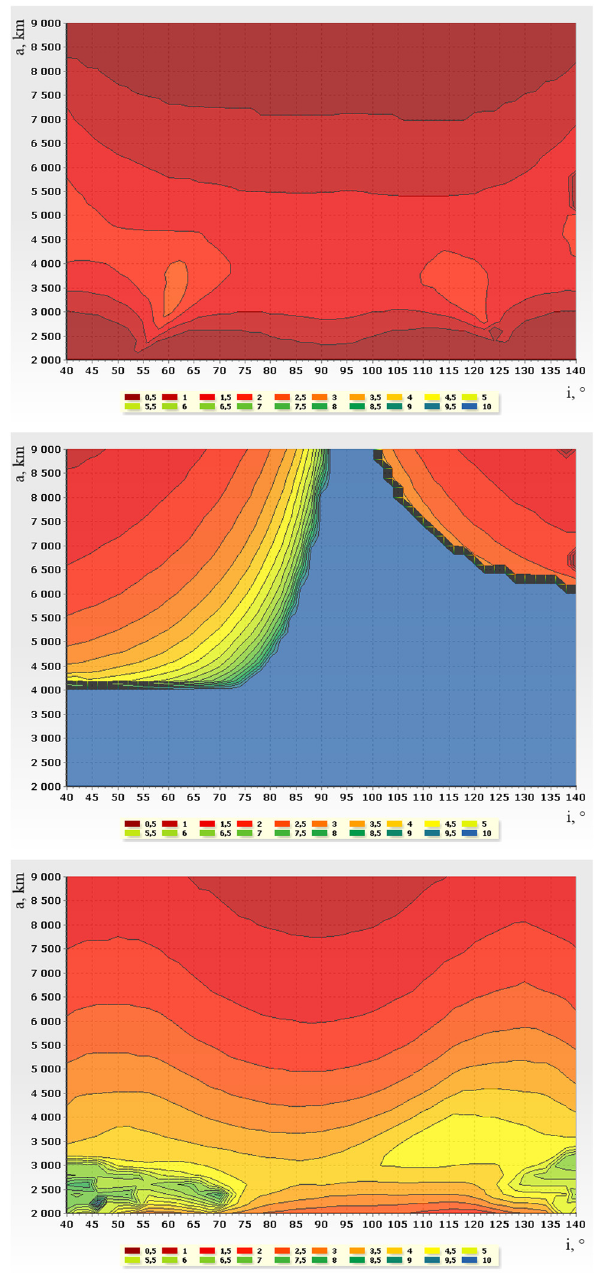
Figure 2: Circular orbit stability areas: eccentricity evolution for 0.01, inclination evolution for 10°, and delta - RAAN between orbit evolution for